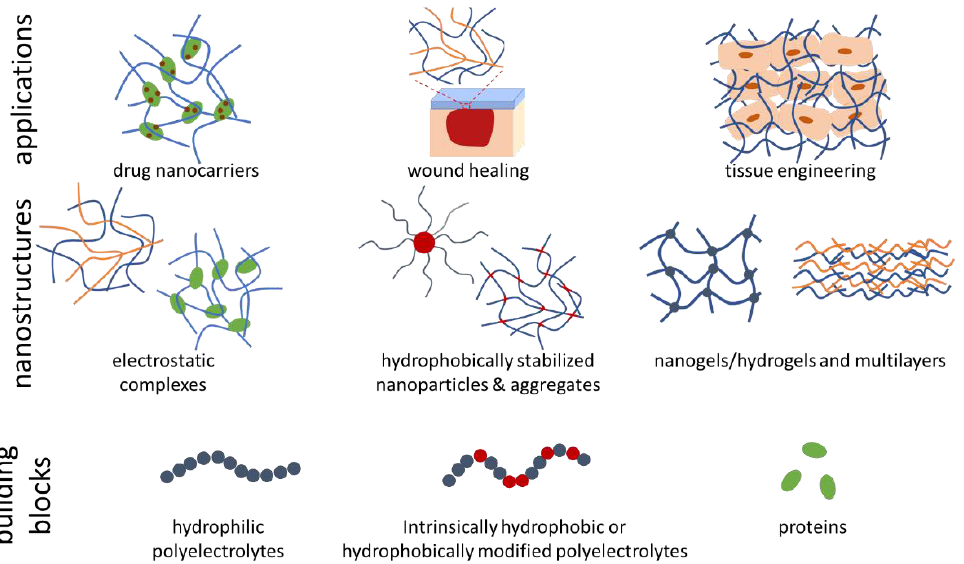
Figure 1. Illustrated examples of polyelectrolytes as building blocks, nanostructures and applications in life sciences.